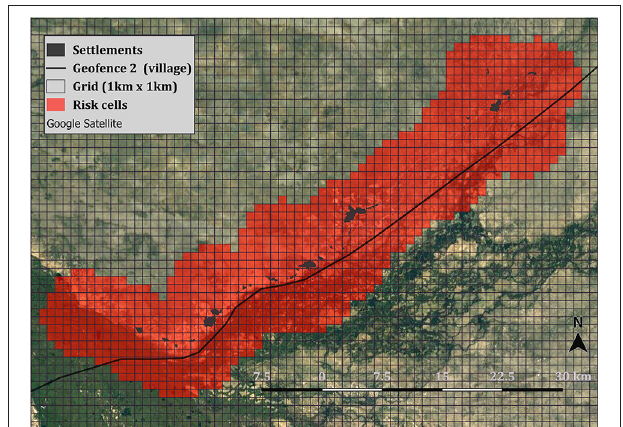
FIGURE 8 | Comparison of Geofence 2 placement with geo-assessment of lion risk to people. Risk was calibrated to the maximum hourly speed moved by any lion in this study (5.47km/h) and mapped into a 1.0km × 1.0km grid across the study area. Red cells indicate risky areas within 1h distance from permanent